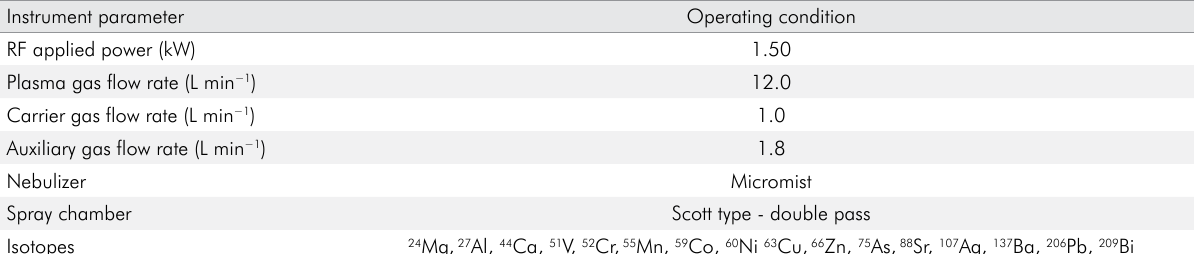
Table 1. Operating conditions for the Agilent 7700